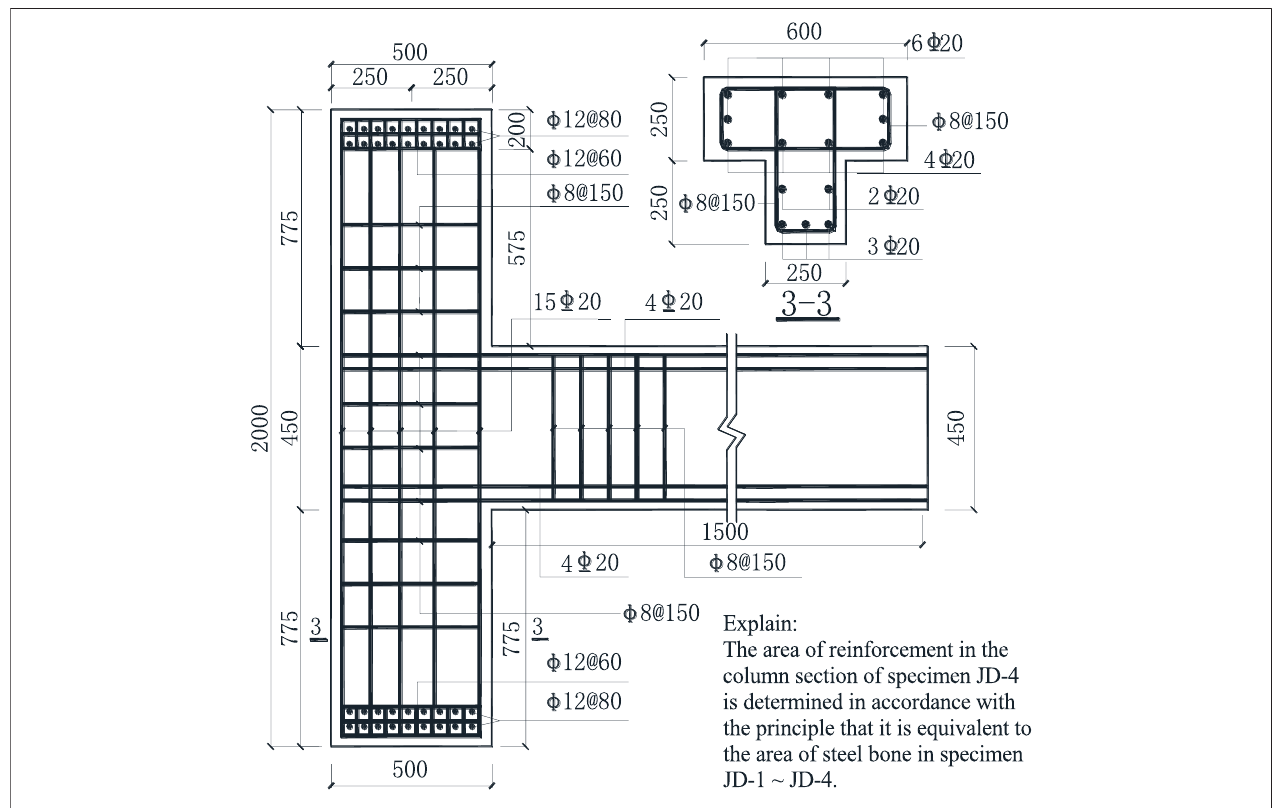
FIGURE 12 | Reinforcement of specimen JD-4 (Xiang et al., 2017; Xiang et al., 2019).